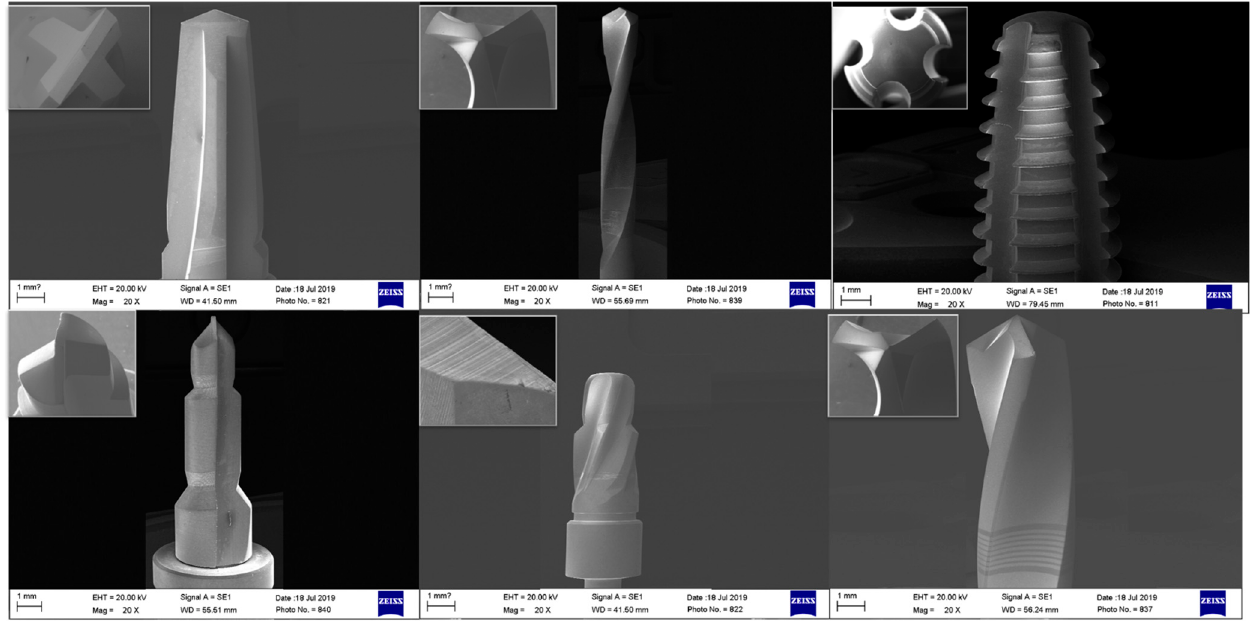
Figure 8. Details of the SEM analysis of the drills used in the present experiment.